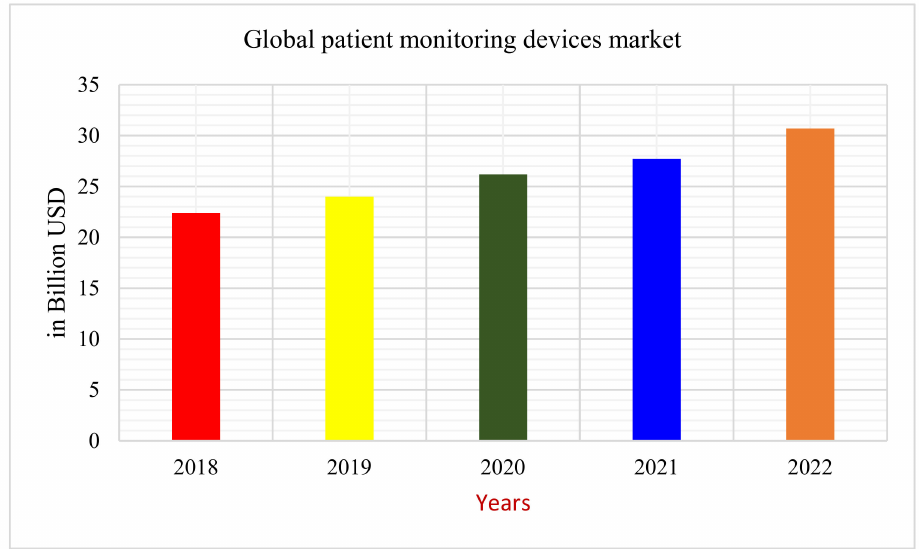
Figure 1. Global market of patient monitoring devices